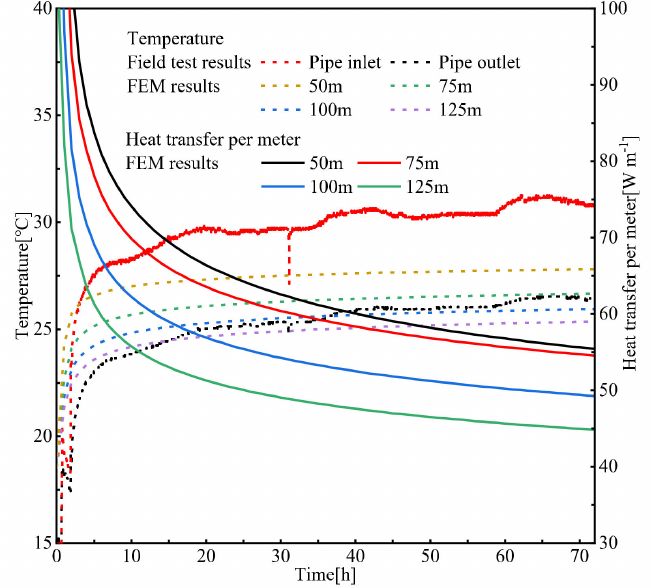
Figure 6. The variation curve of outlet temperature and unit heat exchange of #1 pile under different well depth conditions (5.5